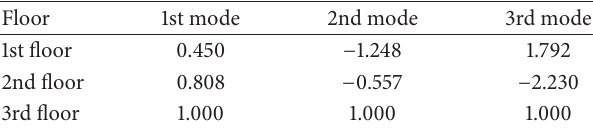
Table 8: Results of mode shape